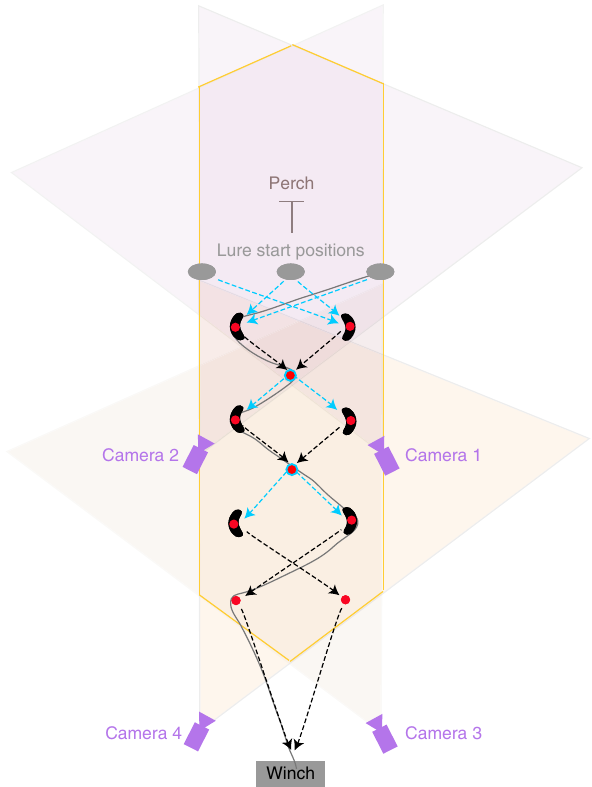
Fig. 7 Schematic of experimental design. Overhead view, with shaded wedges denoting the overlapping fi elds of view of the cameras. The bird began its attack from a perch positioned behind the starting position of the lure (not to scale), which followed a zigzagging course around a series of pulleys (red circles). The lure began moving from one of three covered start positions (grey ovals), and was then pulled around a randomised subset of six from a total of ten pulleys. The lure was always drawn around the two central pulleys (circled blue), but the direction of its motion away from these pulleys was made unpredictable by randomising which of the left or right outer pulleys the lure was drawn towards (blue arrows). Outer pulleys were covered by tunnels (black curves), to guide the lure and to motivate chasing behaviour. The experimenter attempted to keep the lure ahead of the hawk until the end of the course, by controlling the speed of the lure. The lure ’ s start position was randomised on each trial, as was the subset of outer pulleys around which the lure was pulled, giving a total of 16 possible courses for the lure to follow. Dummy lines were laid to avoid the bird reading the course that had been laid ahead of the fl ight. An illustrative lure trajectory is shown as a grey line. Blue dashed arrows denote sections where the lure ’ s direction of travel was unpredictable; black dashed arrows denote sections of the lure ’ s trajectory where the direction of travel might have been anticipated if the bird had learned that the lure was always pulled towards the central pulleys from the outer